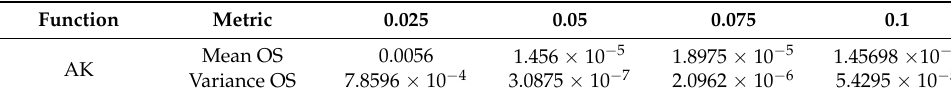
Table 4. Results of different δ in each iteration using the RS function.